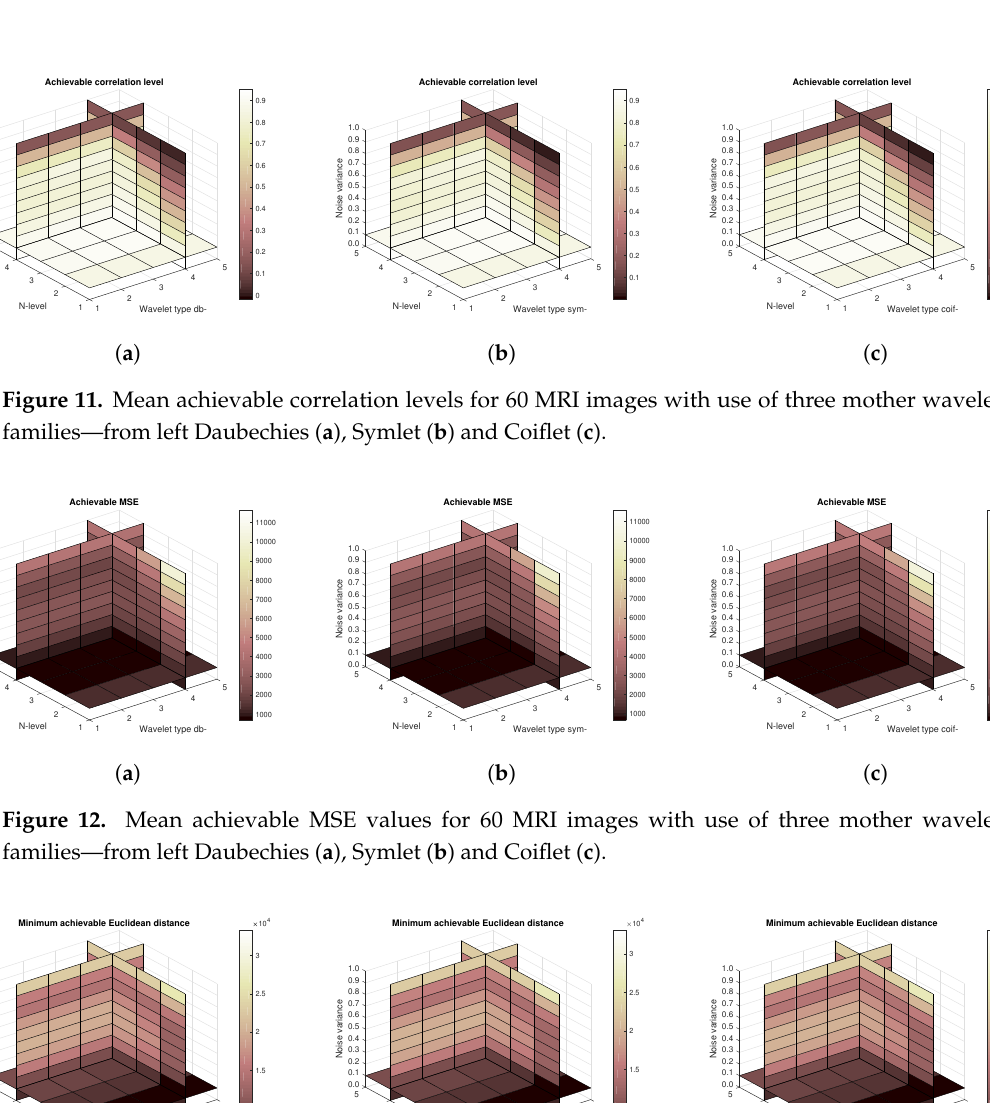
50.20.30.4 0.00.1